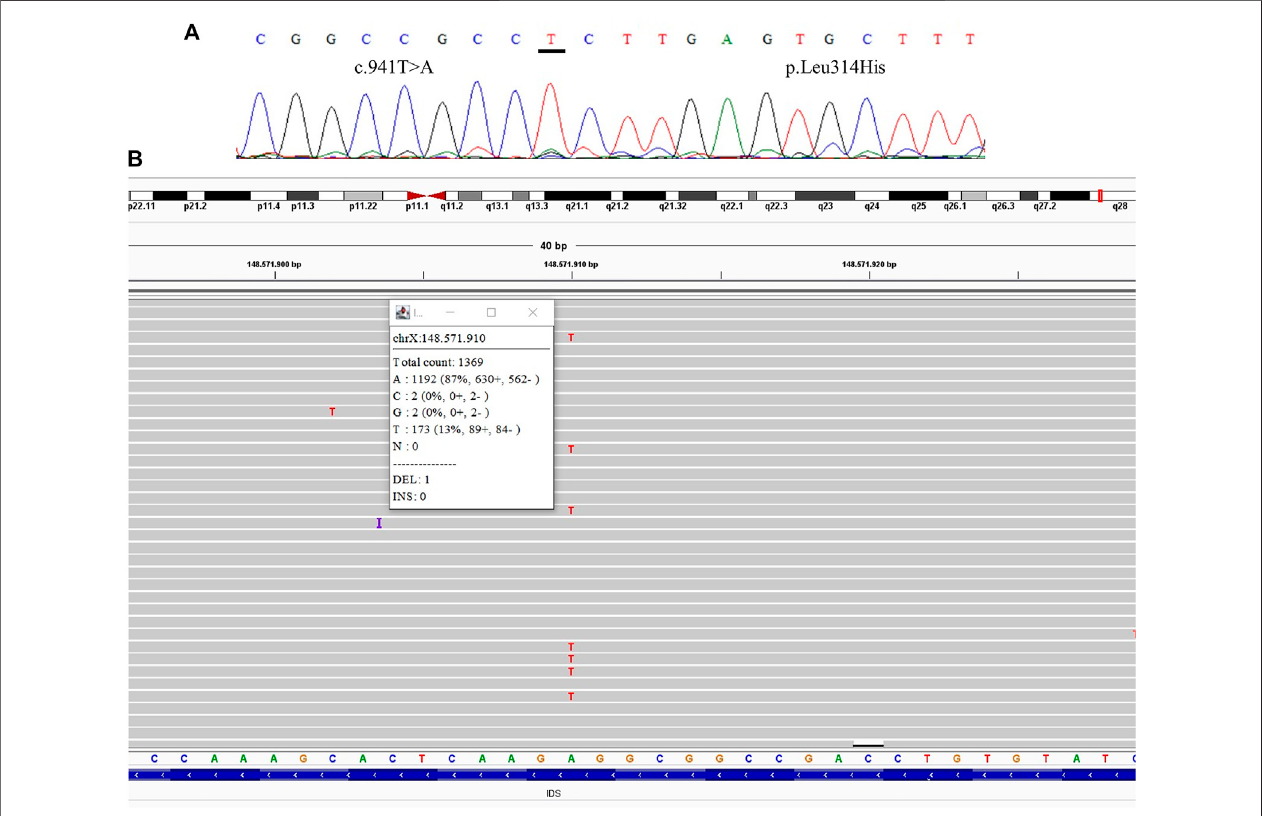
FIGURE1| ComparativeresultsofsangersequencingandNext-generationsequencingatthemutationlocusc.941T > A(p.Leu314His) (A) Sangersequencing (B) Next-generation sequencing showing the coverage of the locus of the mutation, presenting the mutation at a frequency of 13%.